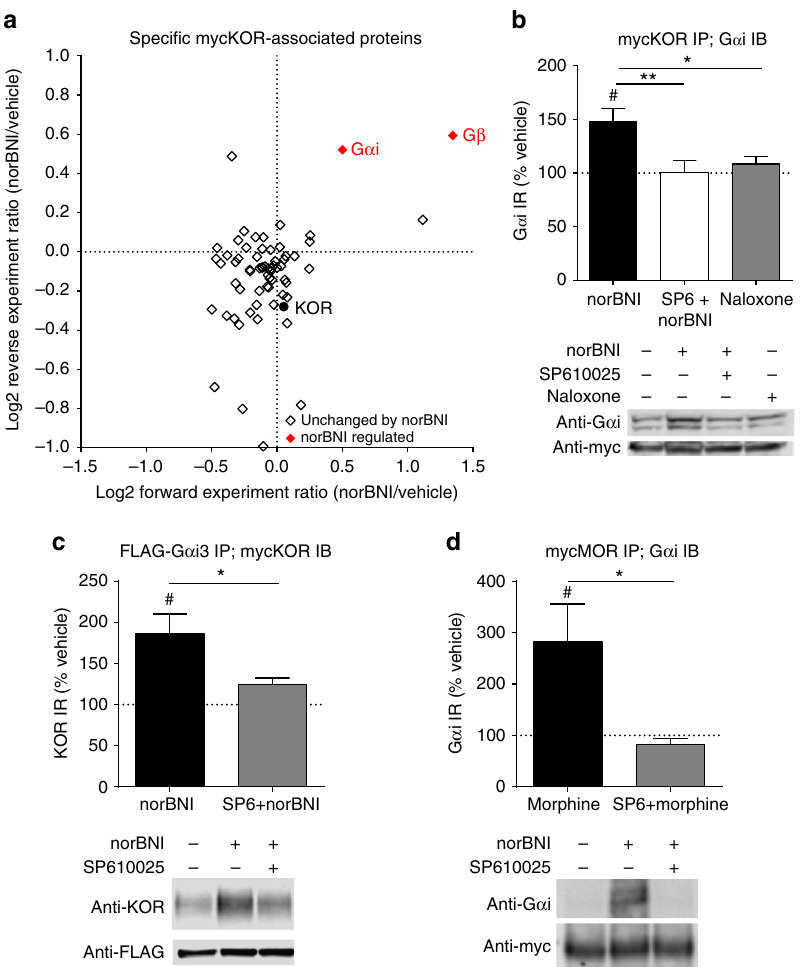
Fig. 1 NorBNI treatment increases KOR-G α i association in a JNK-dependent manner. a Scatterplot of mycKOR-interacting proteins, depicting the ratio of norBNI/vehicle of the forward and reverse replicate. For experiment design, see Supplementary Fig. 2a; for individual proteins, see Supplementary Data 1. Proteins increased by norBNI in both replicates are displayed in the upper right quadrant , and proteins whose associations were decreased by norBNI treatment in both replicates are shown in the lower left quadrant . Proteins whose associations were signi fi cantly changed by norBNI treatment (norBNI/vehicle log2 ratio > 0.5 and signi fi cance B P -value < 0.05 in both replicates) are indicated in red . b NorBNI (10 µ M) signi fi cantly increased G α i immunoprecipitated with myc in mycKOR-expressing cells (#, one sample t -test, correction for multiple comparisons); this increase was blocked by 1 µ M SP610025 and was not observed following 10 µ M naloxone (one-way ANOVA, P < 0.01, n = 8-13; * P < 0.05, ** P < 0.01, Holm – Sidak post hoc analysis). c NorBNI signi fi cantly increased KOR immunoprecipitated with FLAG in mycKOR and FLAG-G α i3 expressing cells (#, one sample t -test, correction for multiple comparisons), and was blocked by SP610025 pretreatment (*, Student ’ s t -test, P < 0.05, n = 6-7). d Morphine (10 µ M) signi fi cantly increased G α i immunoprecipitated with myc in mycMOR-expressing cells (#, one sample t -test, correction for multiple comparisons) and was blocked by SP610025 pretreatment (*, Student ’ s t -test, P < 0.05, n = 4 – 7). Error bars represent mean ±